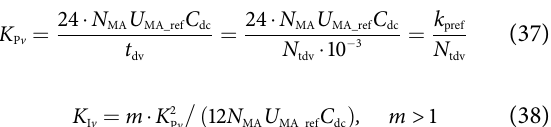
Fig. 10 Root locus diagram of the current loop.